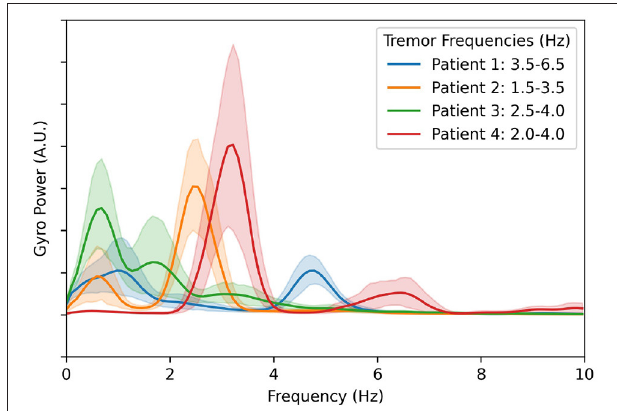
FIGURE 2 | Averaged gyroscope magnitude power spectra from all movement periods during all experiments and calibration sessions with DBS turned off. The first peak in each patient’s tremor spectrum above 1.5 Hz is considered to be the patient’s peak tremor frequency. The resulting frequency ranges used to estimate tremor severity for each patient are shown in the